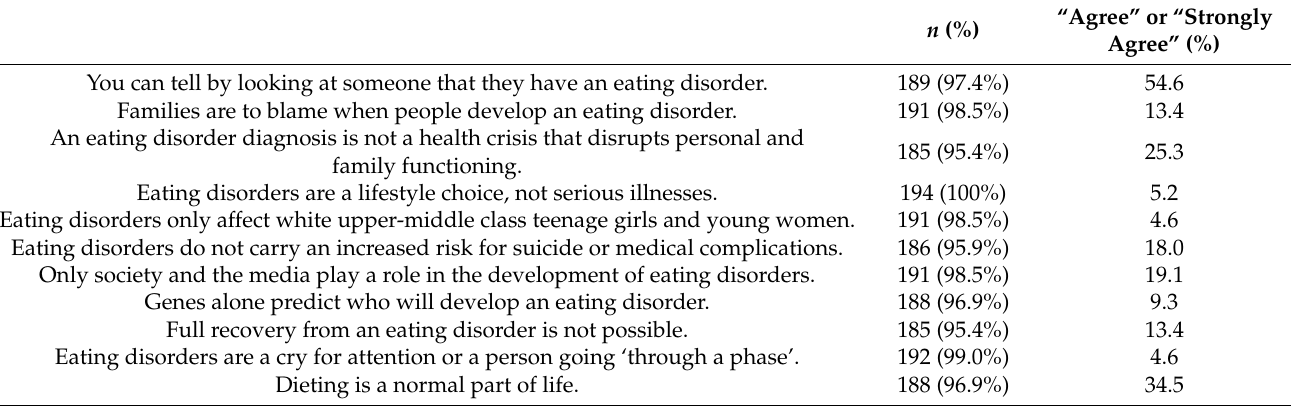
Table 2. Text and percentage of participants who “agree” or “strongly agree” with the 11 ED myths.